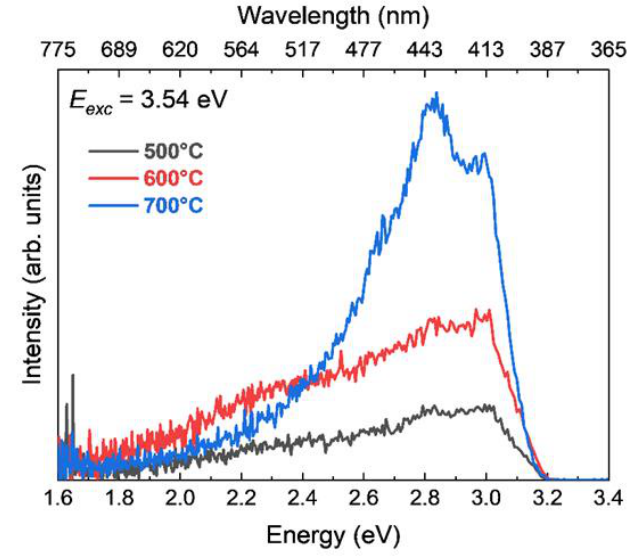
Figure 4. Photoluminescence spectra of TiO 2 nanotubes with UV excitation energy (3.54 eV).